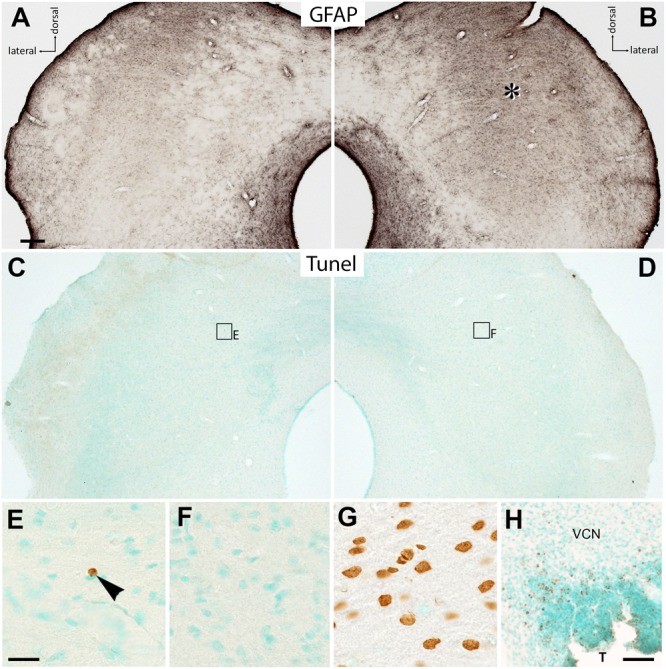
Absence of stimulation-related cell death. (A,B) CIC of a deafened rat by 1 d EIS and stained for GFAP, showing elevated staining levels contralateral to EIS (asterisk). (C,D) In a nearby section stained for Tunel, rare instances of positive staining unrelated in position to the region of high GFAP were found. (E) Frame in (C) at higher magnification showing a single Tunel-positive cell (brown nucleus) in CIC i to 1 d EIS (arrowhead). (F) In the region of high GFAP staining, Tunel-positive cells were equally rare. (G) Positive control of Tunel staining kit shows a lot of positive cells (brown). (H) Tunel staining in numerous cells (brown dots) bordering a tumor (T) that has grown in the ventral cochlear nucleus (VCN) in a rat not otherwise considered in this study. Scale bar for (A–D): 200 μm; scale bar for (E–G): 20 μm; scale bar for (H): 100 μm.